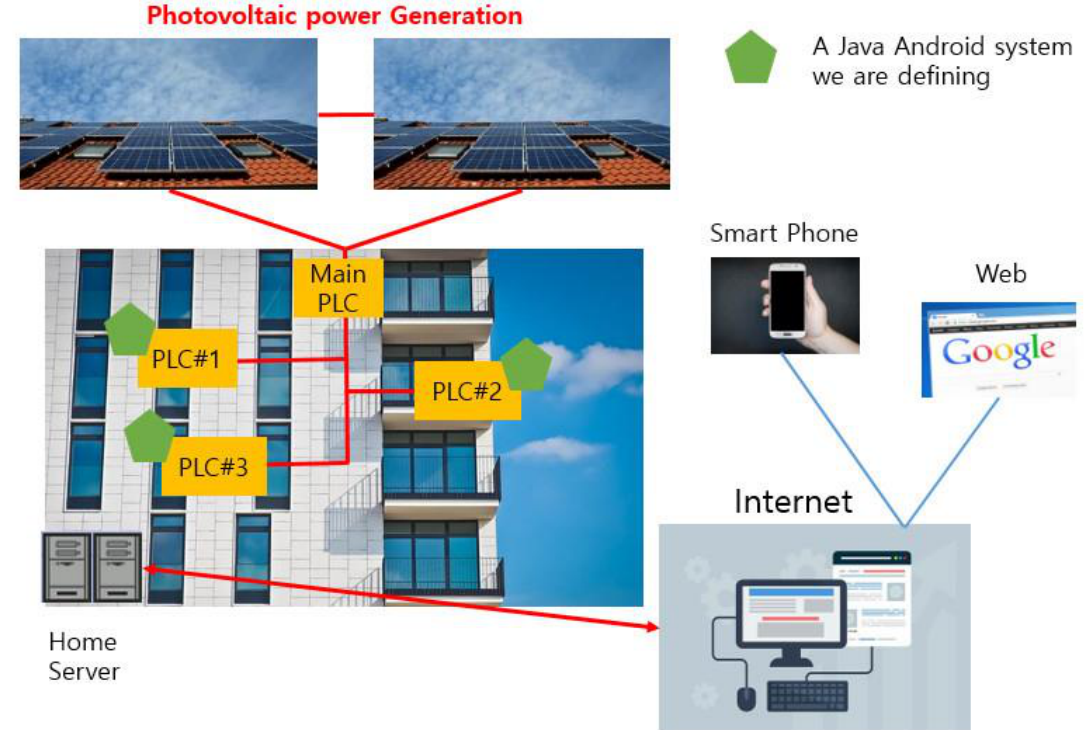
Figure 4. Aerial view of the system installation.